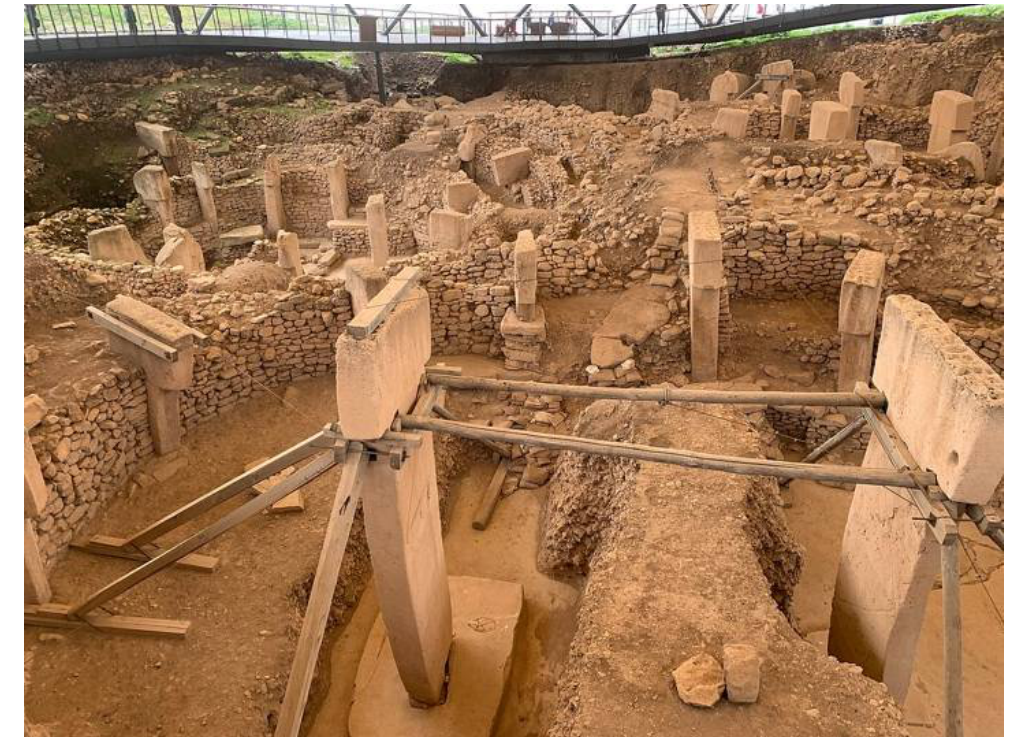
Figure 1. Göbekli Tepe, Enclosure D (Image courtesy of Wikimedia Commons).